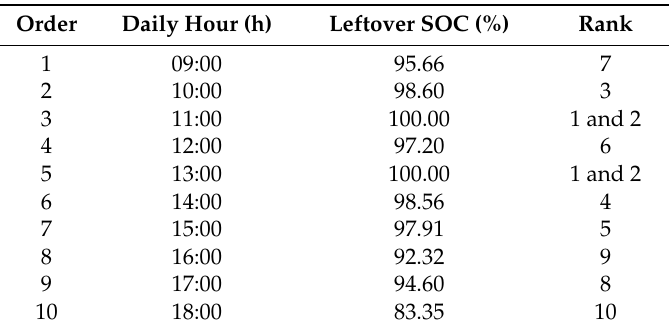
Figure 12. Calculated SOC of the battery pack: ( a ) SOC profiles and ( b ) leftover SOC. Table 3. Leftover SOC.